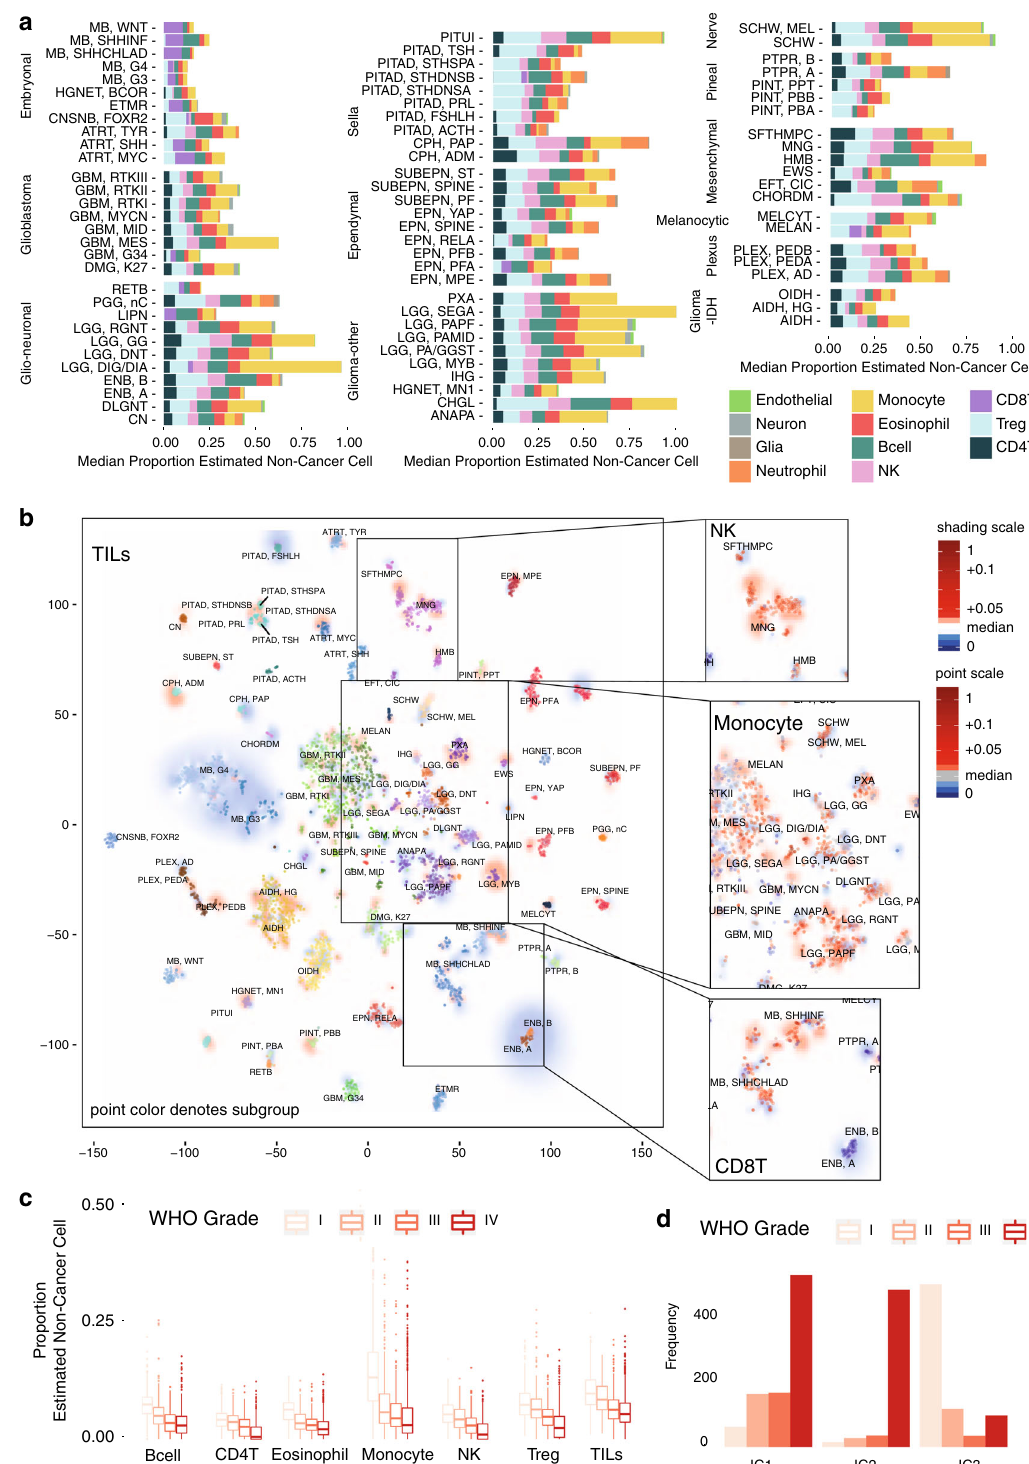
I – VIII 35 . These subtypes are also associated with differences in estimated levels of each cell type with the exception of monocytes (each p < 0.002, see Supplementary Data 1). Post hoc analysis shows the most signi fi cant differences to be CD8T (greater in subtype II), Tregs (less in subtype II), NK (greater in subtype VIII), and B-cells (less in subtype III) (all comparisons p < 0.01) (Fig. 3a, b). Signi fi cant differences were apparent between MB SHH